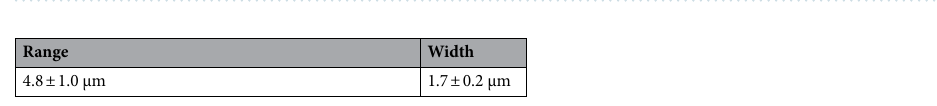
Table 2. Measured average ranges evaluated for several alpha-particle trajectories for low-energy alpha source.